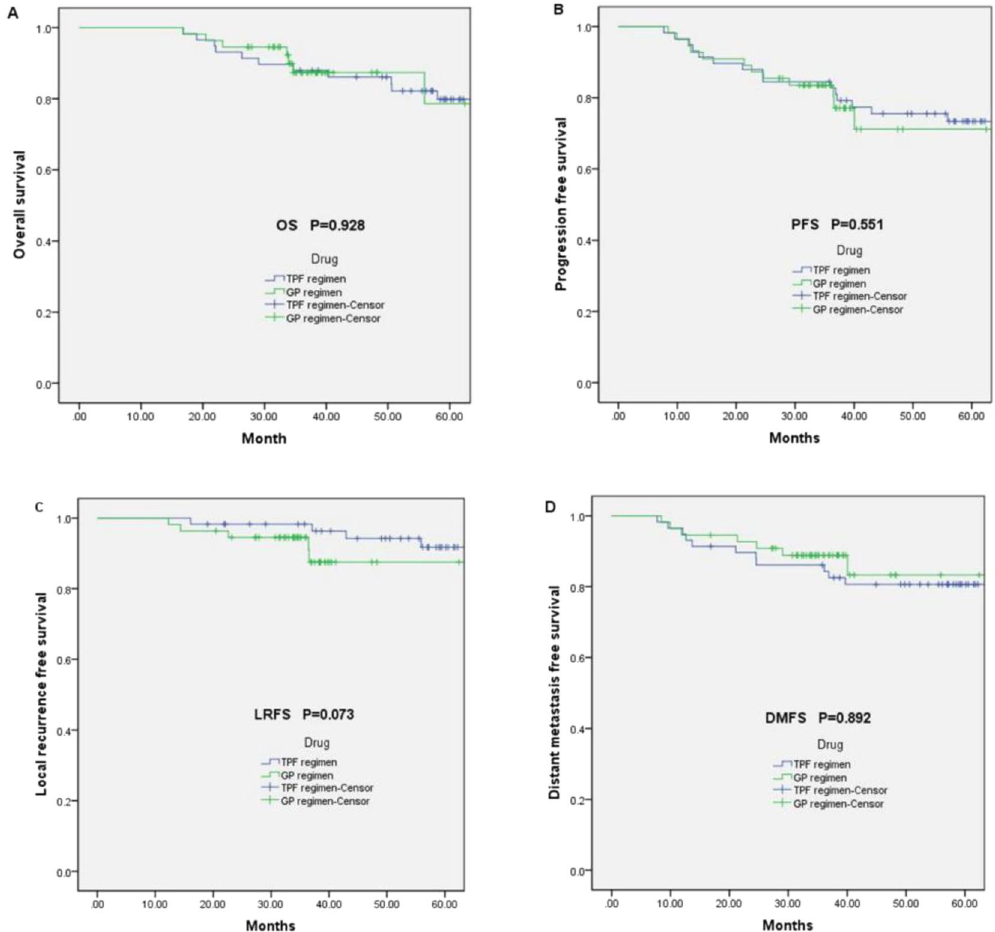
Figure 2. Kaplan–Meier survival curves. ( A ) Kaplan–Meier curve estimates for OS; ( B ) Kaplan–Meier curve estimates for PFS; ( C ) Kaplan–Meier curve estimates for LRFS; ( D ) Kaplan–Meier curve estimates for